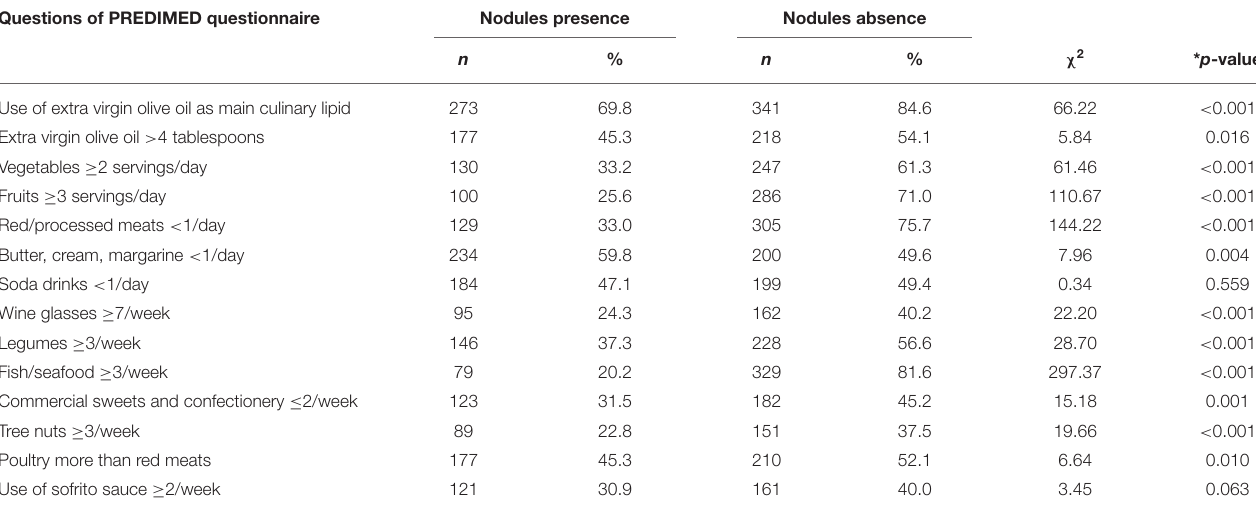
TABLE 3 | Response frequency of dietary components included in the PREDIMED questionnaire according to presence/absence of thyroid nodular disease. Questions of PREDIMED questionnaire